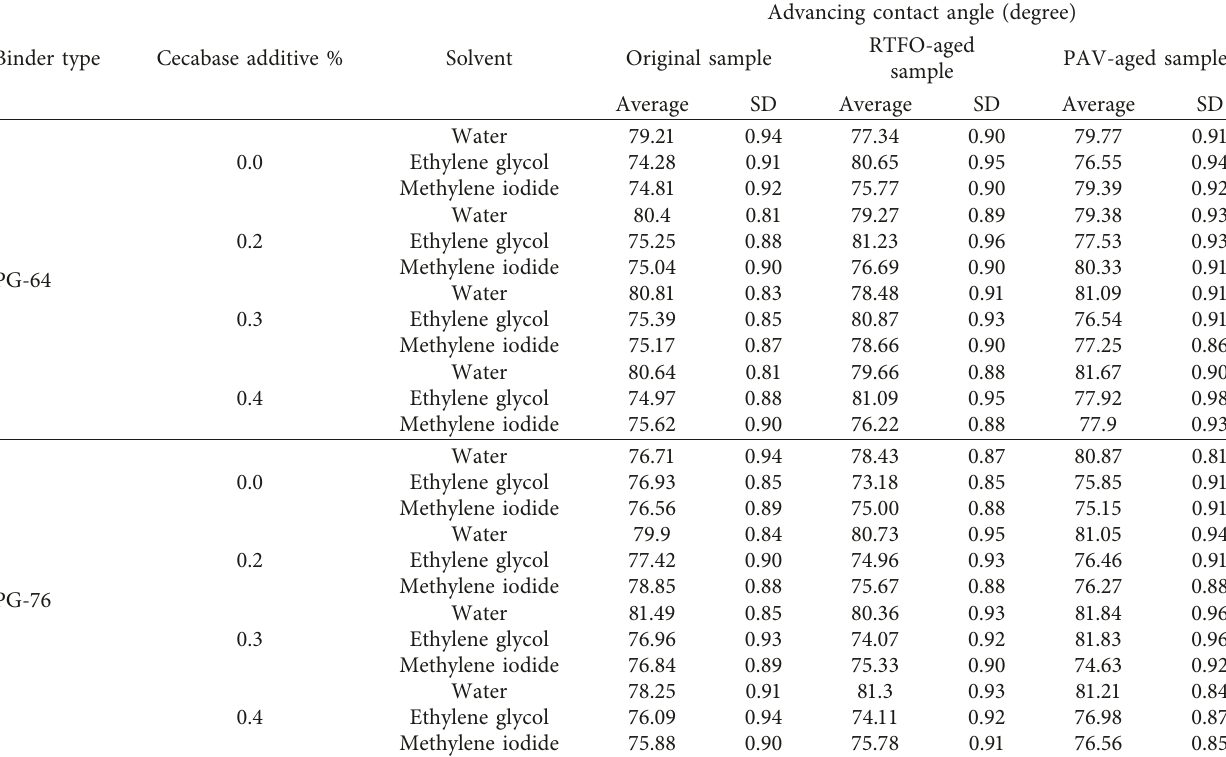
Table 5: Advancing contact angle of asphalt binders.